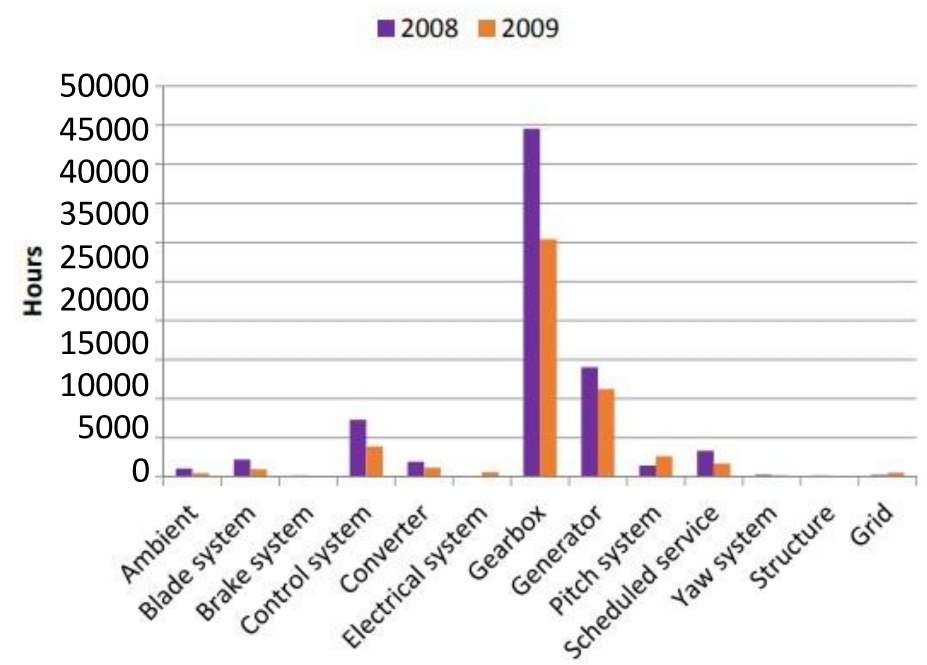
Figure 2. Downtime Caused by WTs in the Egmondaan Zee Wind Farm in the Netherlands in 2008 and 2009